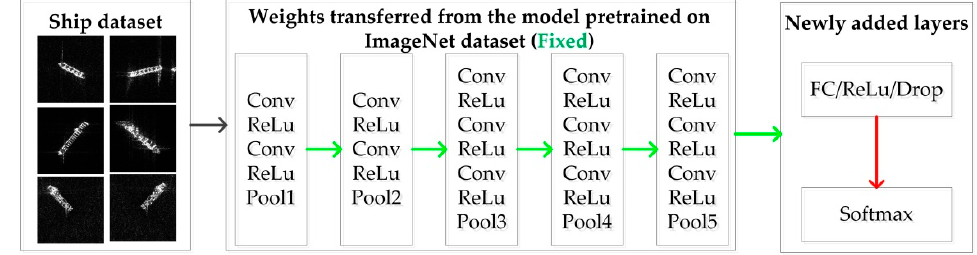
Figure 6. Workflow of training using transfer learning on the ship dataset for ship classification based on VGG16. The red arrows indicate that the weights involved in these layers will be learned, and the green arrows represent that the parameters will remain unchanged.